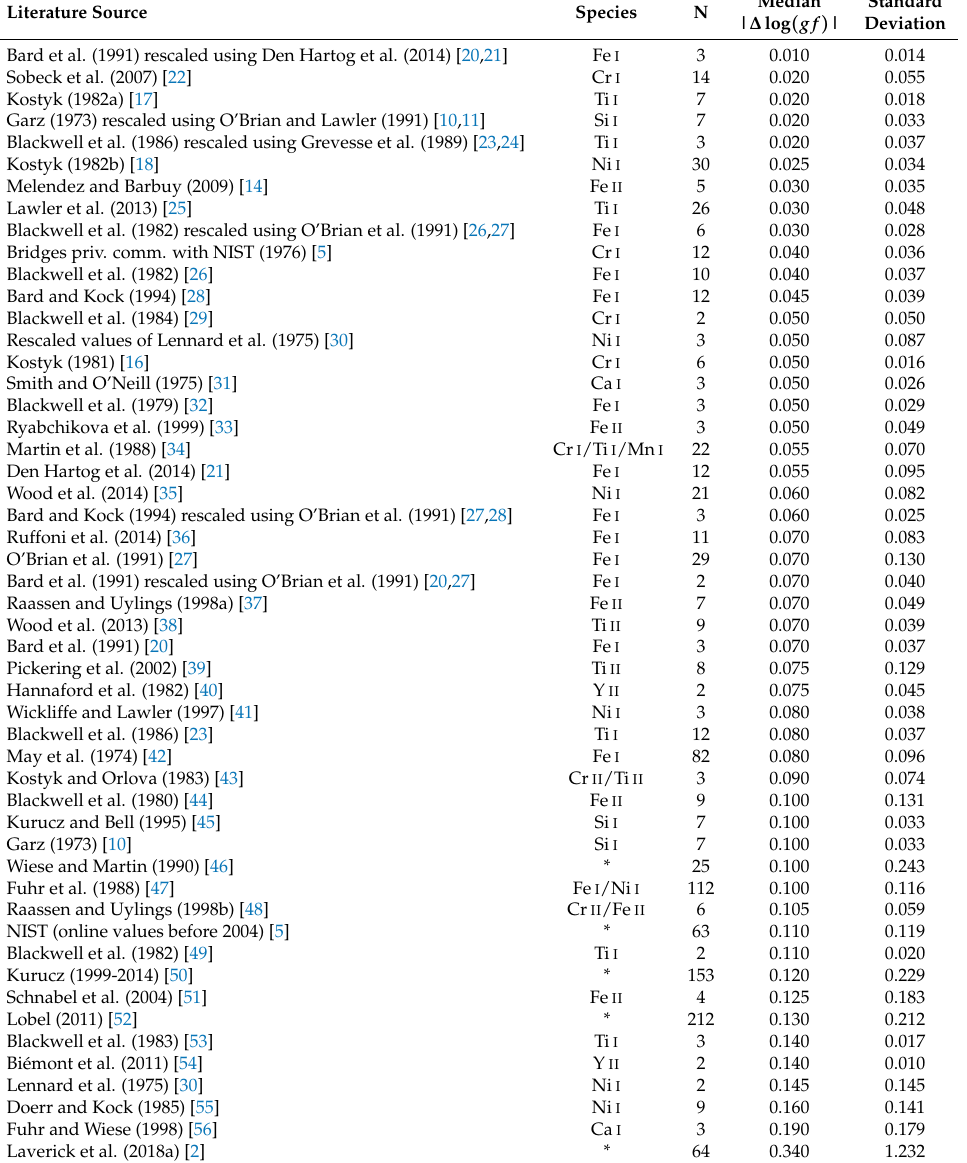
Table 1. Literature sources with data for two or more of the 383 recommended atomic lines present in G-type stellar spectra. References are sorted in ascending order according to the median of the absolute ∆ log ( gf ) between the given literature values and the best overall atomic data values. References with lines belonging to several species are denoted with